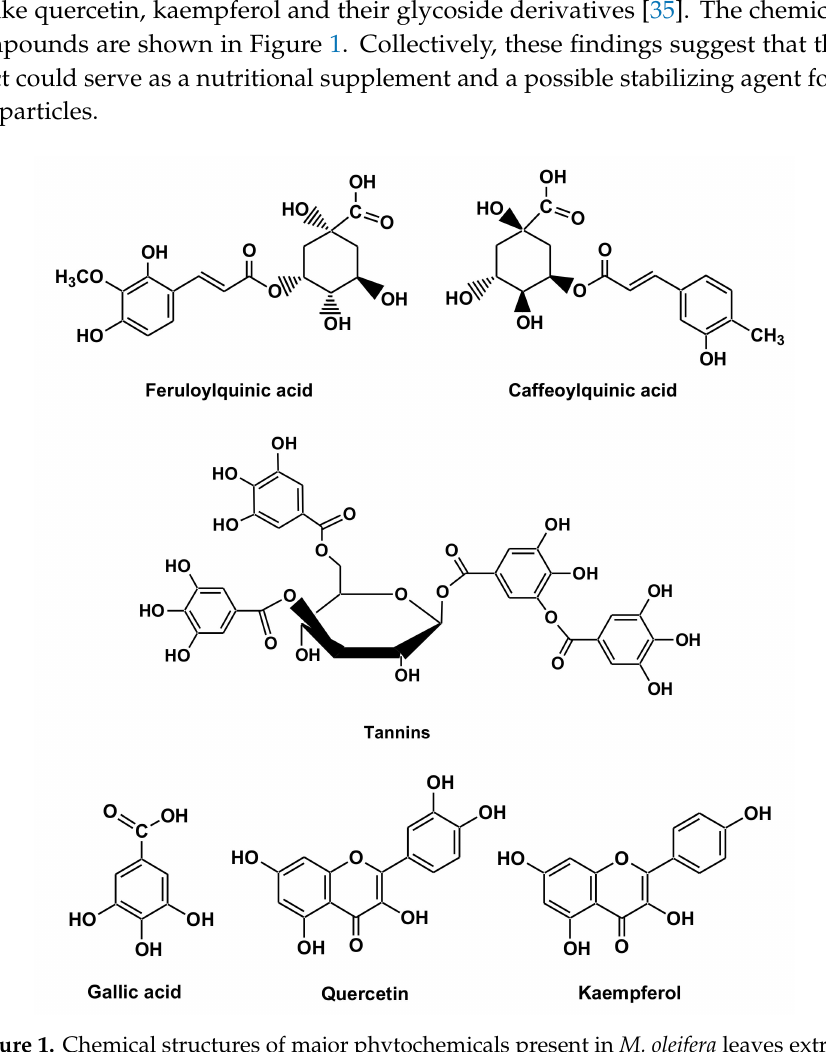
Figure 1. Chemical structures of major phytochemicals present in M. oleifera leaves